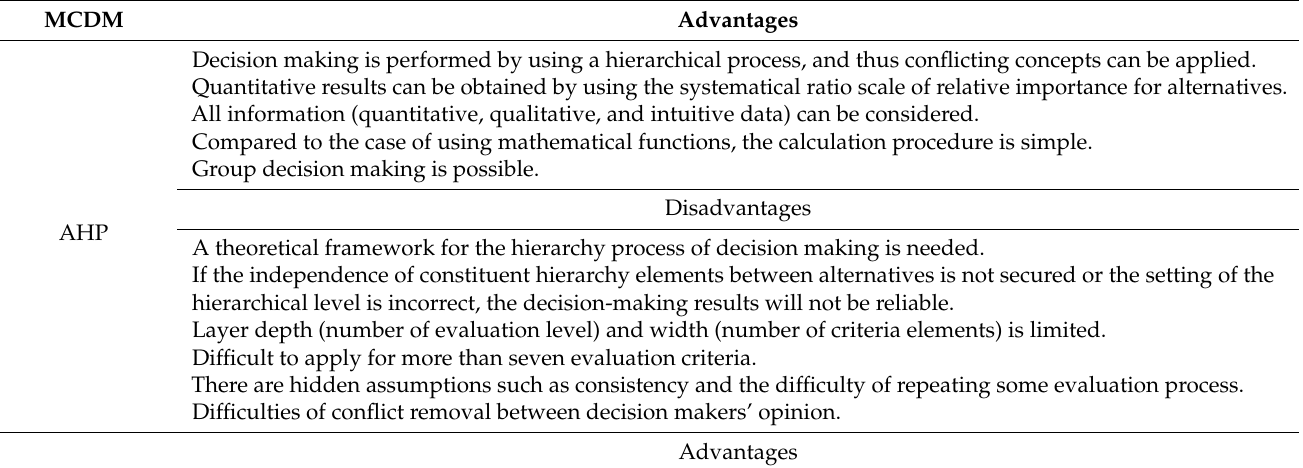
Table 10. The advantages and disadvantage of MCDM